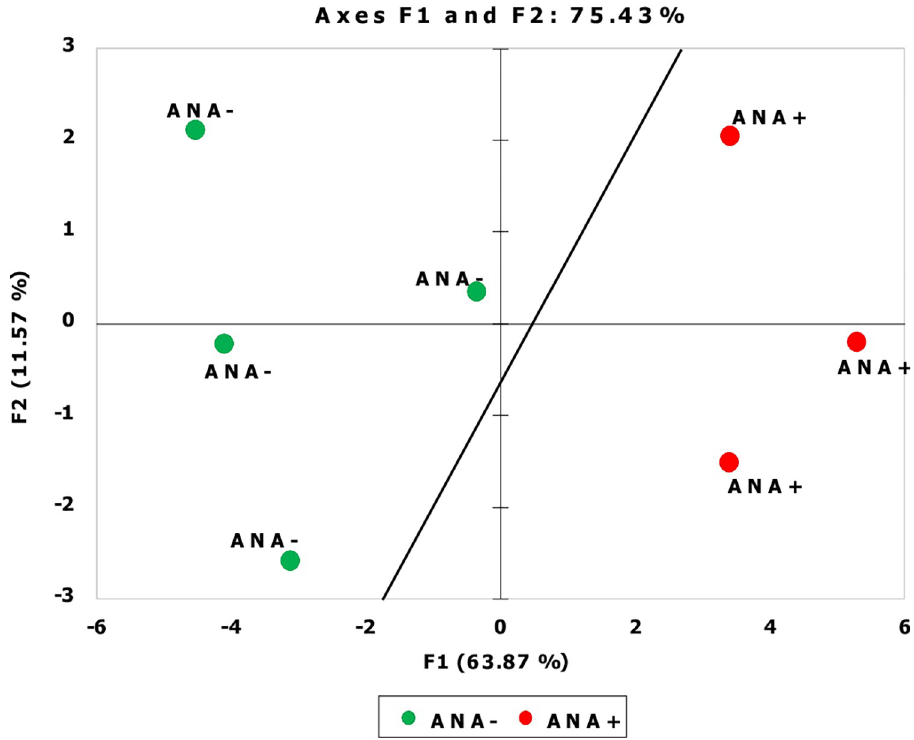
Fig 4. STRING analysis of exosome proteins from patients with Raynaud’s Phenomenon with positive ANA compared to patients with Raynaud’s Phenomenon with negative ANA. Protein–protein interaction network was created based on analysis of 12 proteins out of 22 proteins from the comparison of samples with Raynaud with positive ANA vs Raynaud with negative ANA. k-means = 3 clusters indicated by node color. Solid line represents within- cluster, dashed lines represent between-cluster